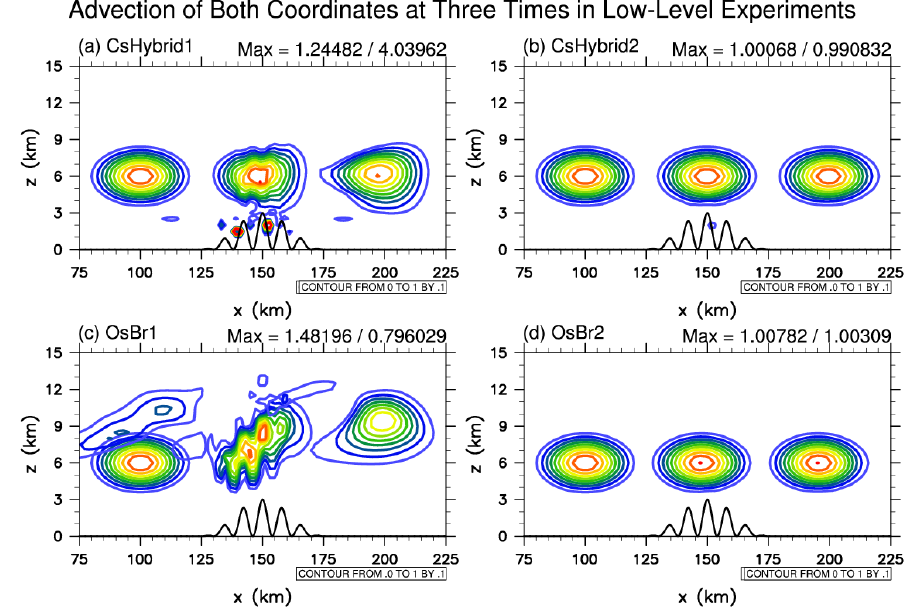
Figure 11. The advection at the beginning, the middle and the end of the integration in the modified Schär-type (low-level) experiments. Coloured contours are the tracer q , with the contour interval of 0.1. The solid black curve in the bottom of each figure represents the mountain.